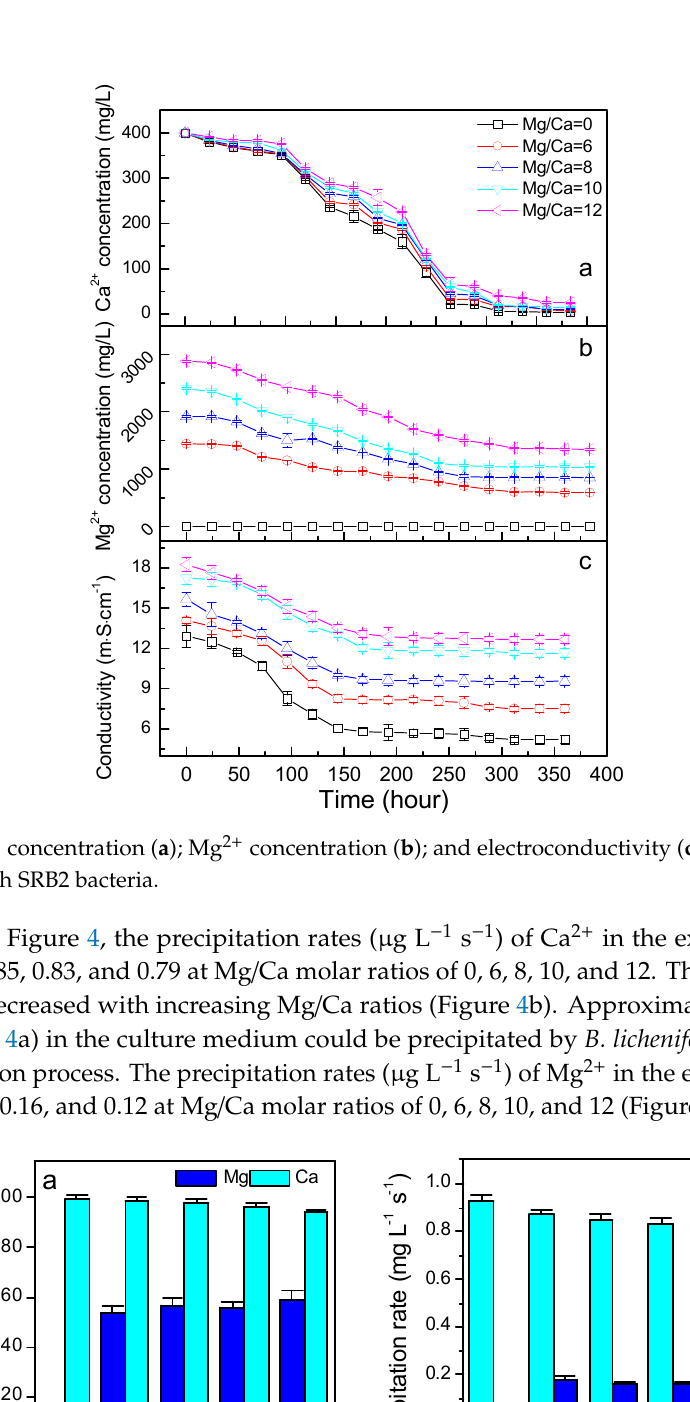
Figure 4. Precipitation ratio (a) and precipitation rate (b) of Ca 2+ and Mg 2+ ions.